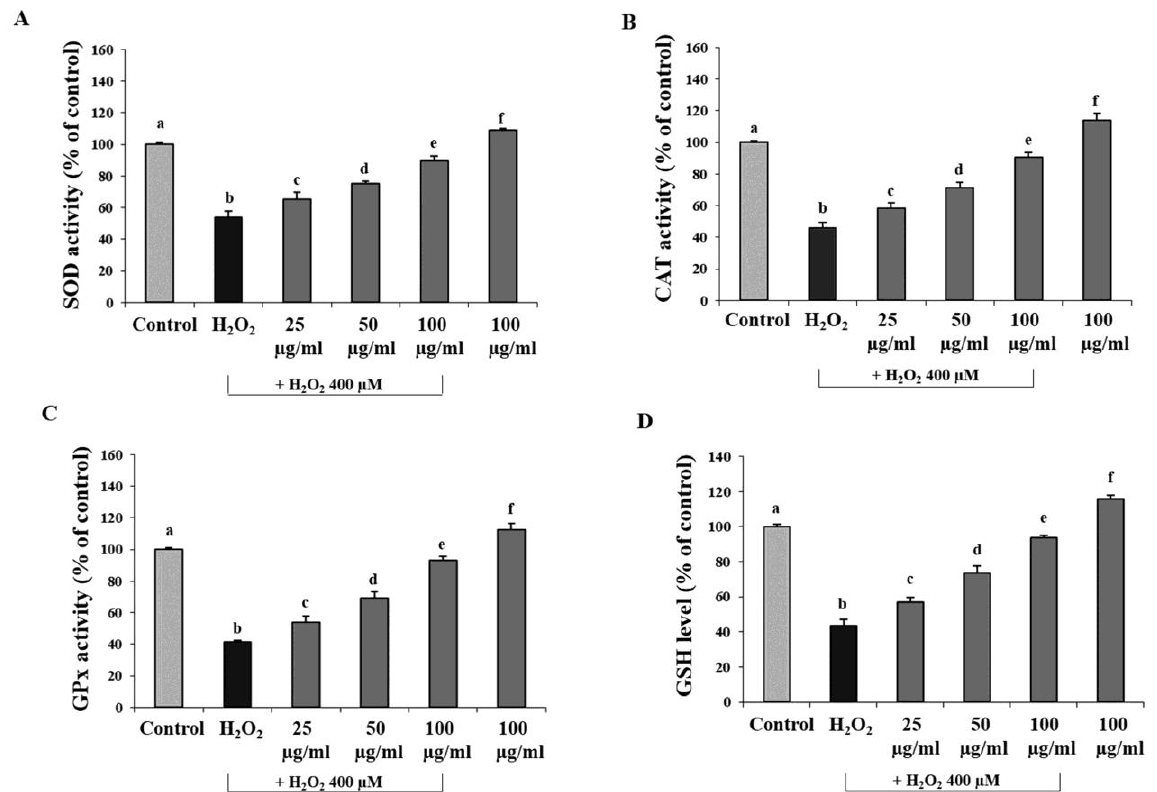
Figure 10. Evaluation of the effect of compound 3 on SOD, CAT, and GPx activities, and GSH levels in oxidative-stress-induced ARPE-19 cells. Cells were pre-treated with compound 3 at 25, 50 and 100 µg/mL for 24 h, followed by incubation with H 2 O 2 at 400 µM for 60 min. ( A ) SOD, ( B ) CAT, and ( C ) GPx activities, and ( D ) GSH levels using the respective assay kits. Results are presented as mean ± SD values ( n = 4). Different superscript letters (a – f) indicate significant differences between values in the column ( p < 0.05).